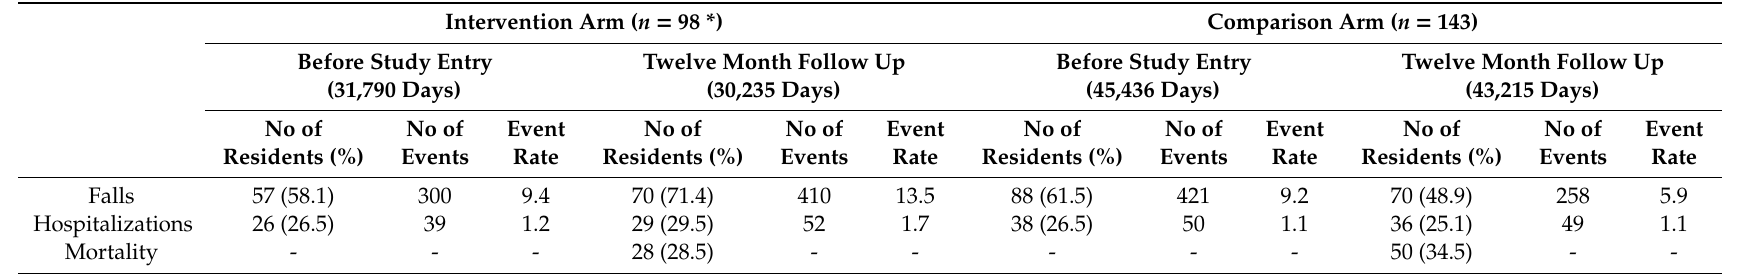
Table 2. Falls, hospitalizations and mortality in the intervention and control arms twelve months prior and post-study entry.